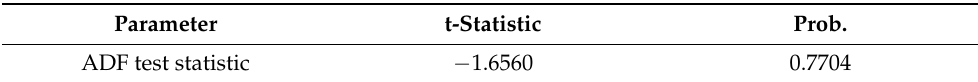
Table 2. Unit Root Test of the Gold Price.